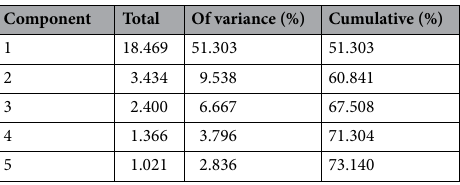
Table 5. Eigenvalues and variance percentages of the five factors.